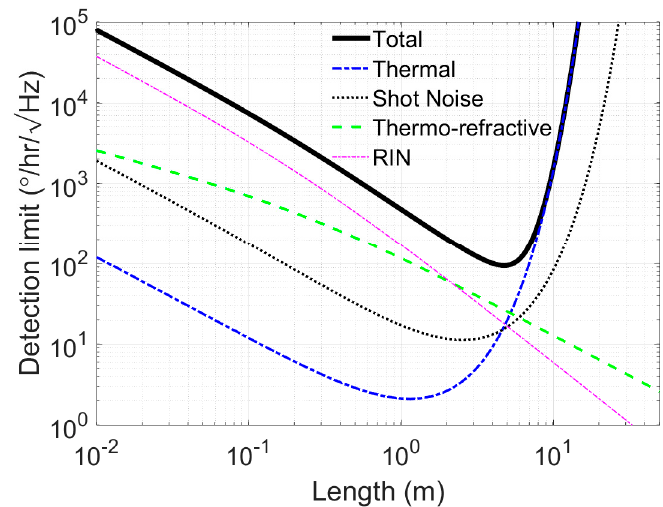
Figure 11. Contributions from various noise sources to the rotation noise spectral density as a function of Sagnac loop length for optical output power P 0 = 100 mW and waveguide propagation loss = 4 dB/m. Calculations were based on the analysis presented in [44].